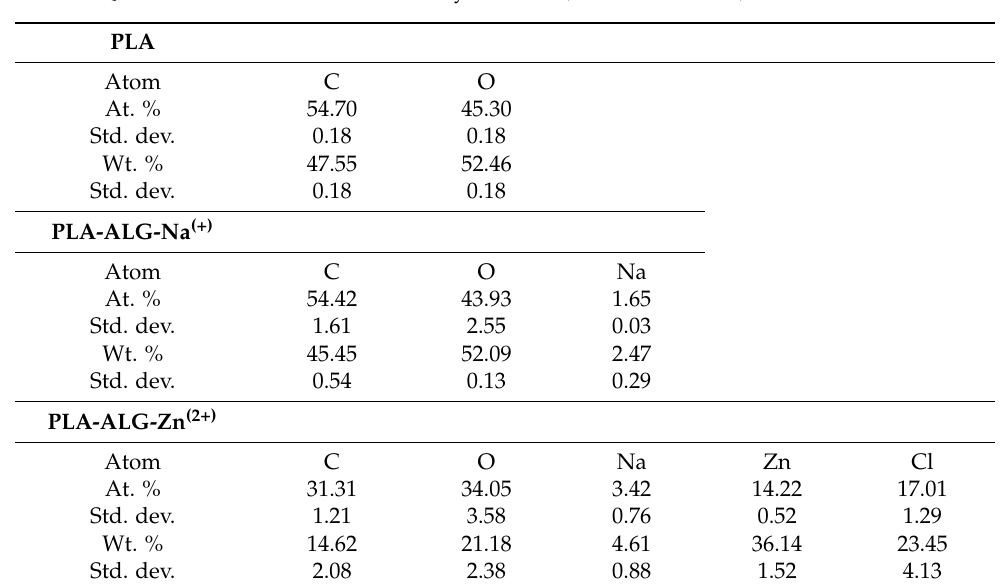
Figure 9. Example of the energy-dispersive X-ray spectroscopy (EDS) spectrum of PLA-ALG-Zn (2+) . Table 3. Quantitative results of the EDS analysis of PLA, PLA-ALG-Na (+) , and PLA-ALG-Zn (2+)